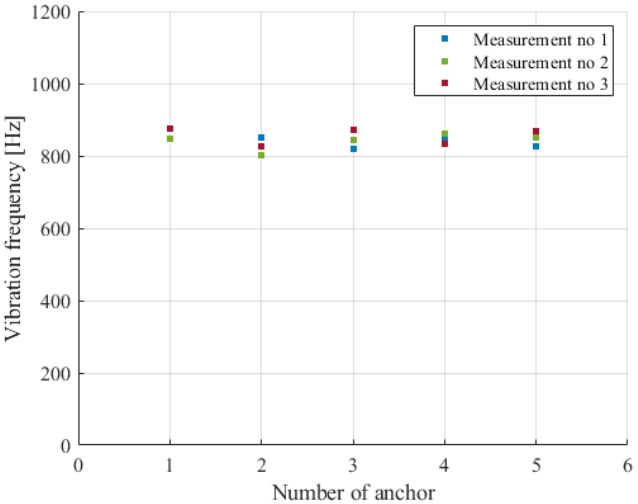
Figure 15. Measurement of anchor vibration frequency in a Klein II transverse with